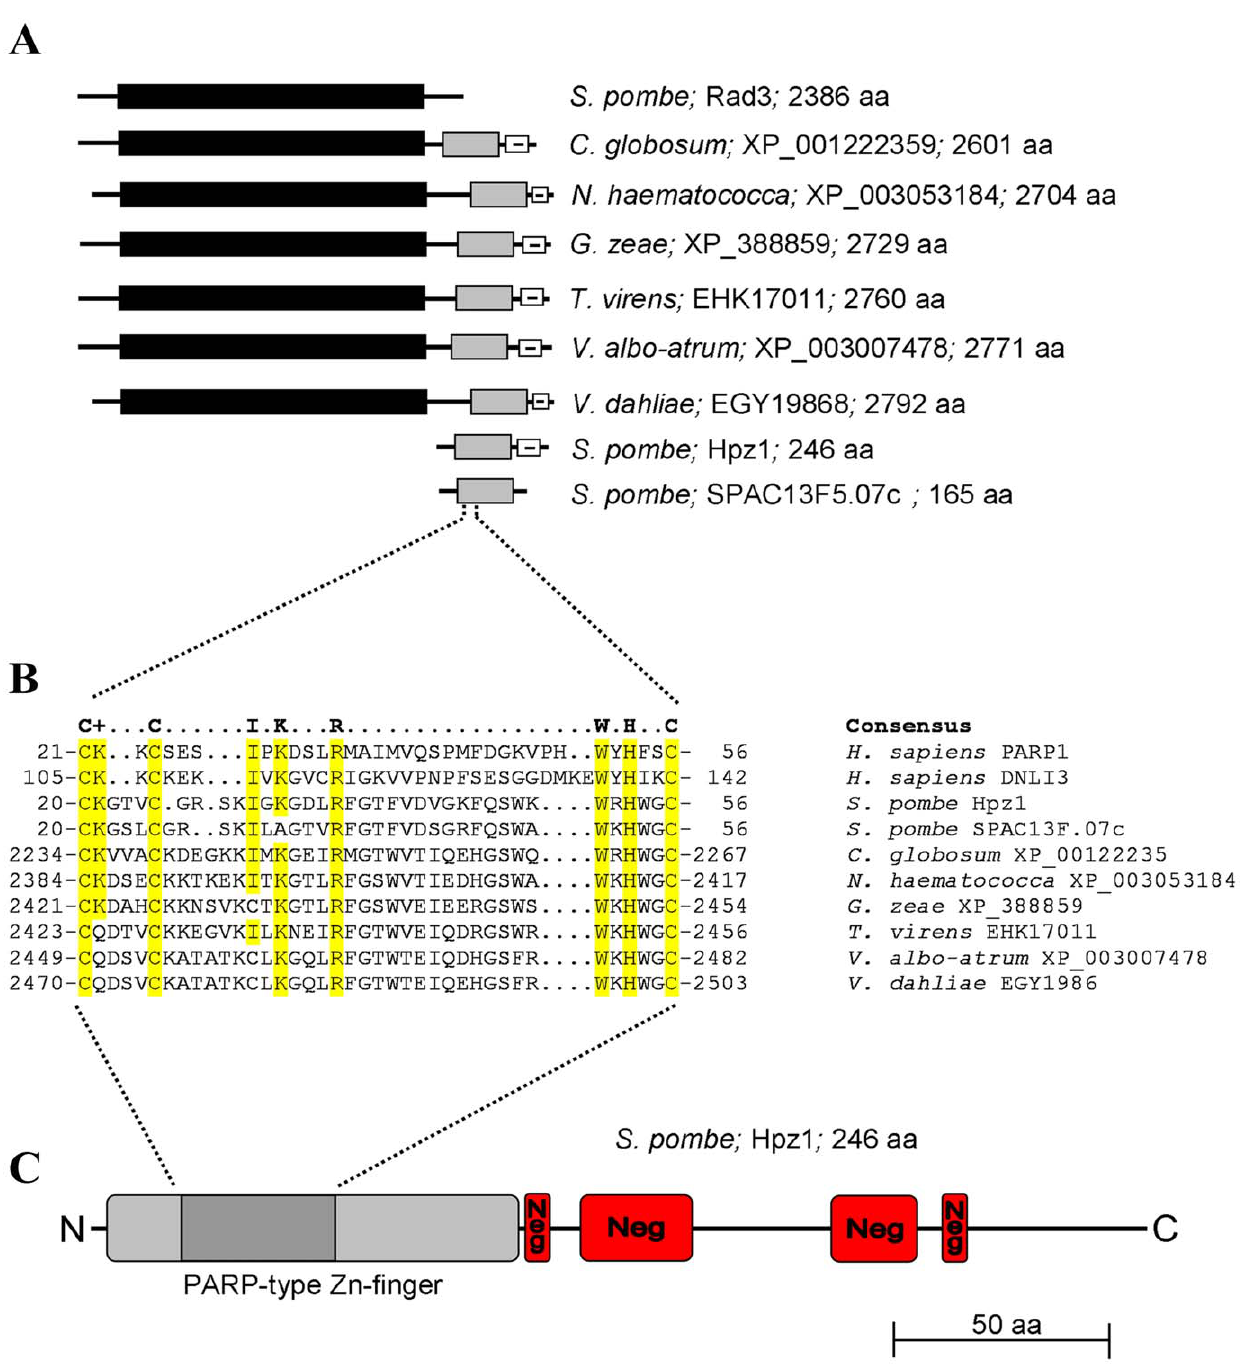
Figure 1. Homology and composition of Hpz1. A. Schematic presentation of Rad3 (black bar) from S. pombe , six Rad3-like proteins in different fungi with a PARP-type Zn-finger domain (gray bar) and a negatively charged C-terminal domain (white bar with minus sign), and the two homologues of the PARP-type Zn-finger found in S. pombe , Hpz1 and SPAC13F5.07c (not drawn to scale). B. Multiple-sequence alignment showing the consensus sequence of the PARP-type Zn-finger domain (IPR001510, http://www.ebi.ac.uk/interpro/) and aligned sequences below. Conserved residues are highlighted in yellow. The numbers in front of and after the sequence indicate the residue numbers. C. Schematic representation of the Hpz1 protein in S. pombe (drawn to scale). Indicated are the PARP-type Zn-finger domain (light gray), the Zn-finger signature sequence used in the multiple-sequence alignment (dark gray) and four regions that show bias towards the negatively charged amino acids glutamate and aspartate (red). doi:10.1371/journal.pone.0044539.g001 progression into and through S-phase (Fig. 3 C and D). To exclude the possibility that hpz1 D cells normally progress Surprisingly, hpz1 D cells seemed to increase their DNA content faster through S phase and therefore spend shorter time in S phase earlier than wild-type cells did. we analyzed asynchronous populations of cells by flow cytometry